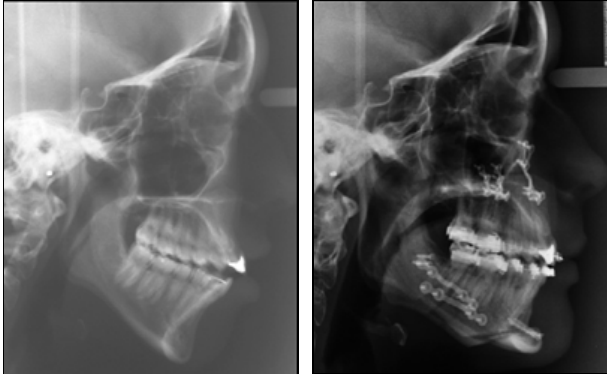
Figure 5. Pre-surgical and post-surgical cephalograms of a patient treated by anti-clockwise rotation of the occlusal plane.